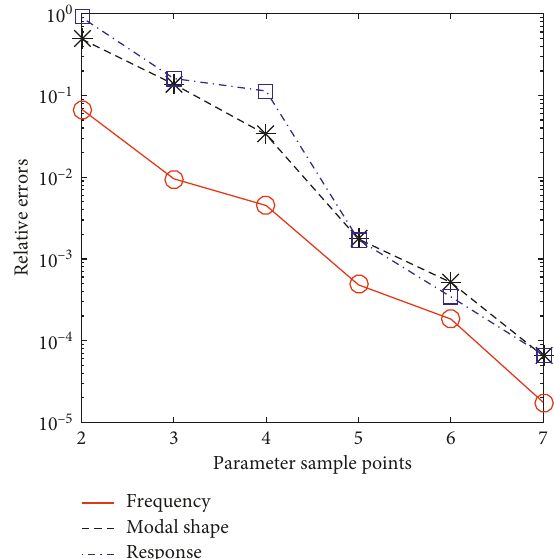
Figure 4: Error evolutions for the automatic sampling methods.